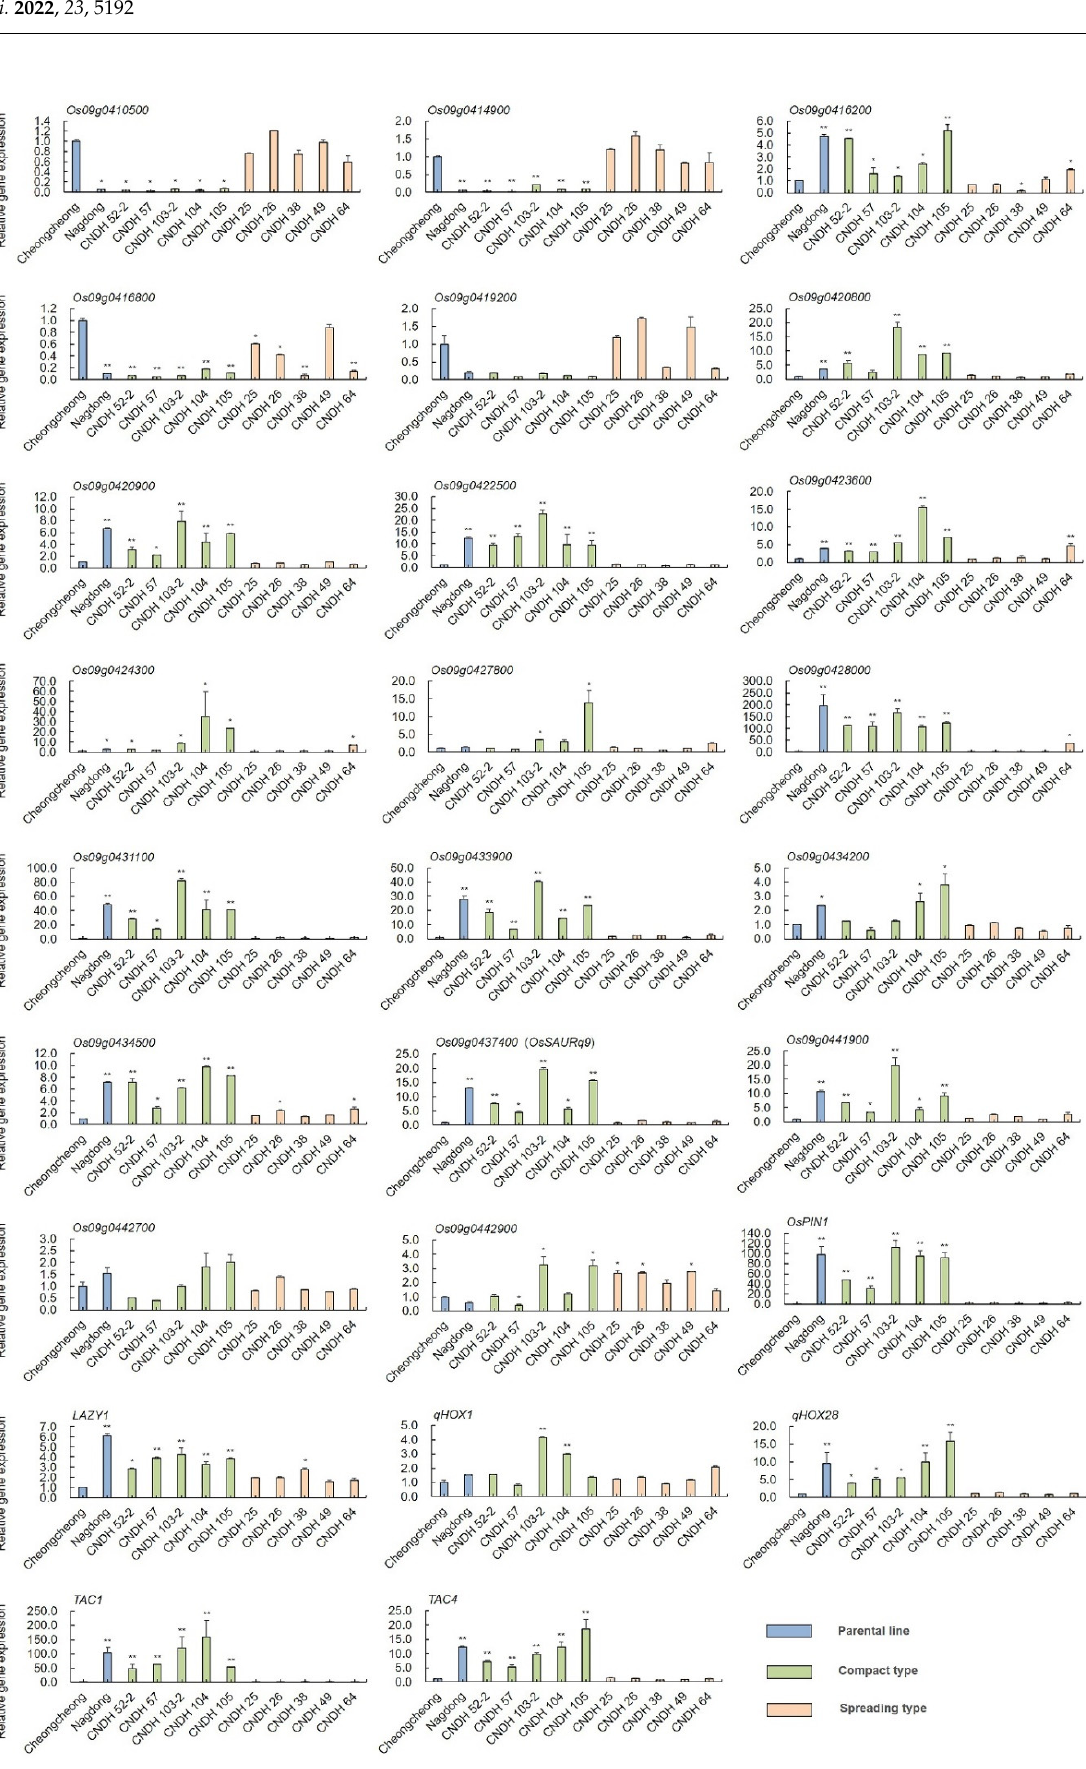
Figure 5. Comparison between the 20 selected tiller angle-related genes by QTL analysis and